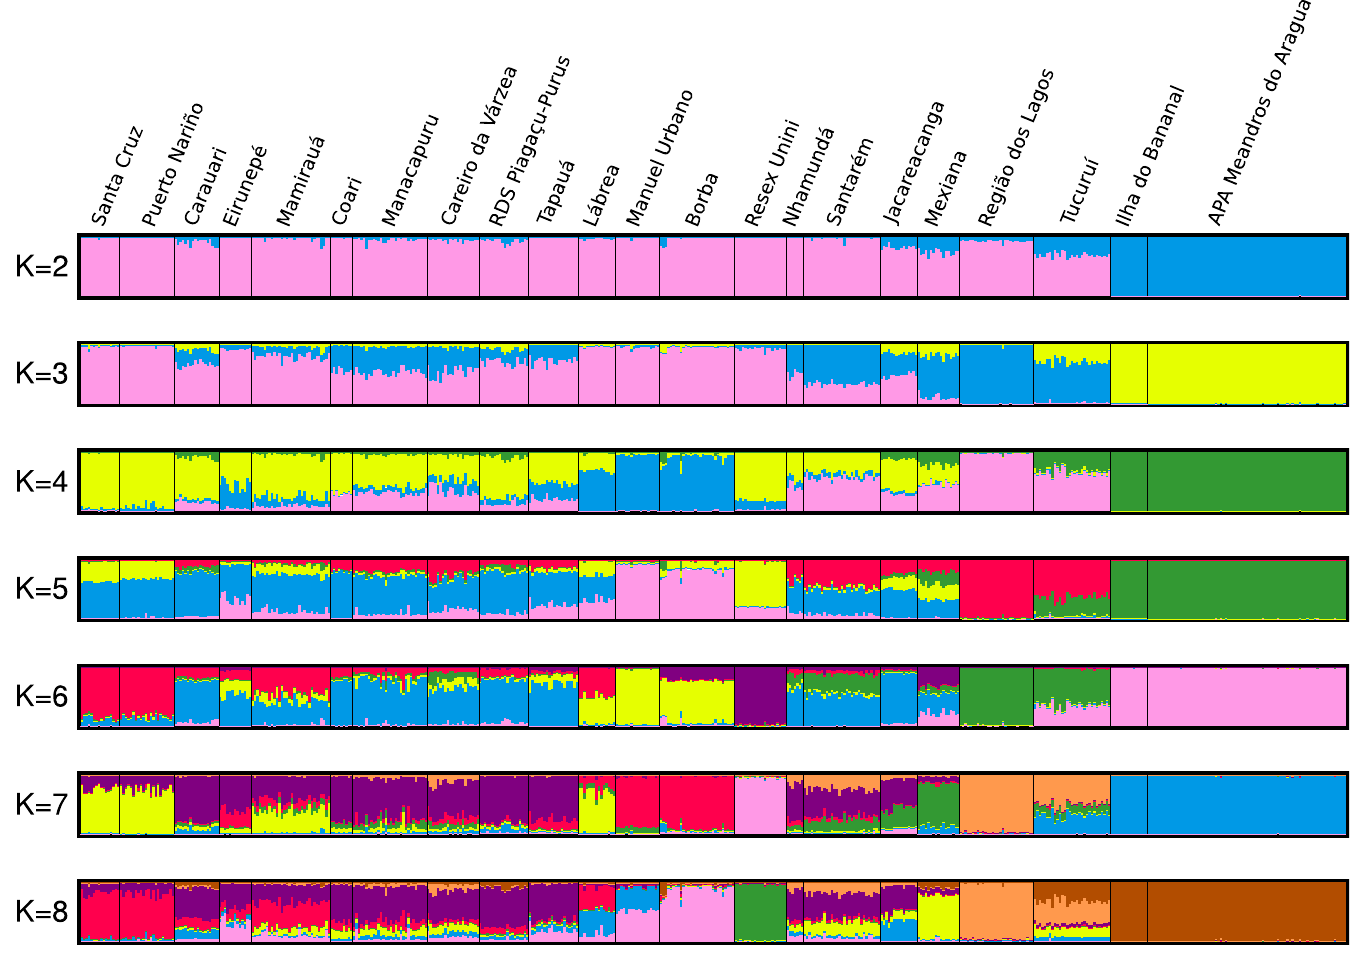
Fig 2. Graph of population structure of Arapaima gigas estimated in the program STRUCTURE. Each individual is represented by a vertical line.